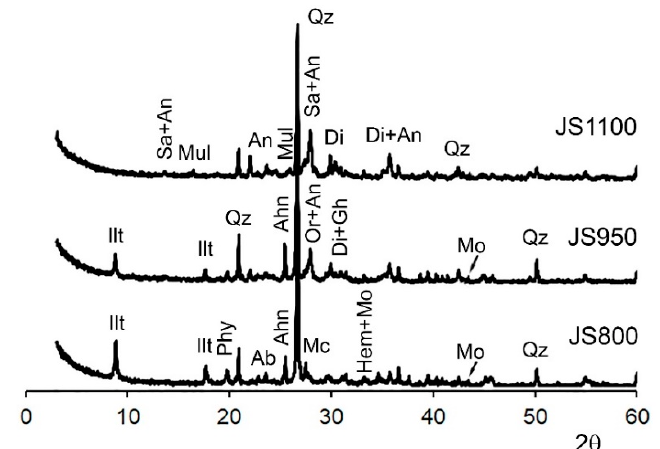
Figure 3. X ray diffraction patterns of bricks with added sodium chloride (JS) fired at 800 °C, 950 °C, and 1100 °C. Legend: Qz = quartz, Ilt = illite/muscovite; Phy: phyllosilicates (in general); Ahn = anhydrite; Hem = hematite; Mc = microcline; Or = orthoclase; Sa = sanidine; Ab = albite; An = anorthite; Gh = gehlenite; Di = diopside; Mul = mullite; Mo = molysite. Minerals abbreviations after Whitney and Evans [55].